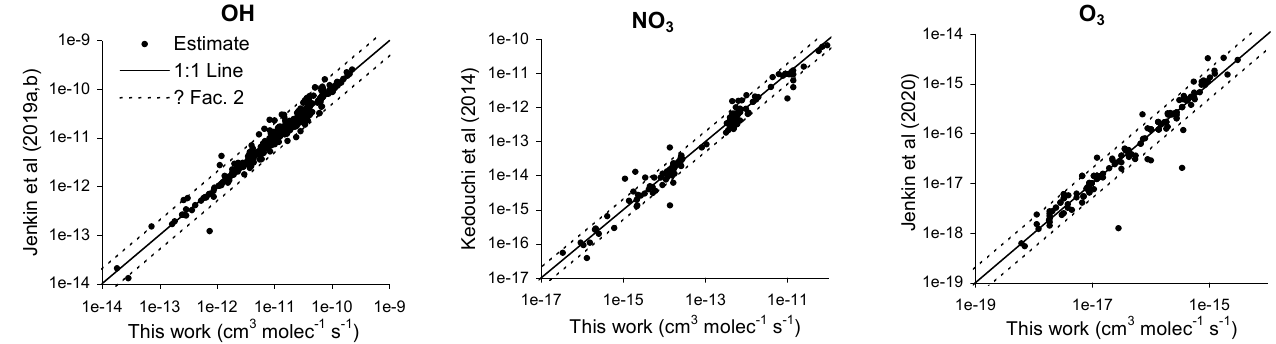
Figure 4. Comparison of estimates from Jenkin et al. [29,30,32] and Kedouchi et al. [31] with those from this